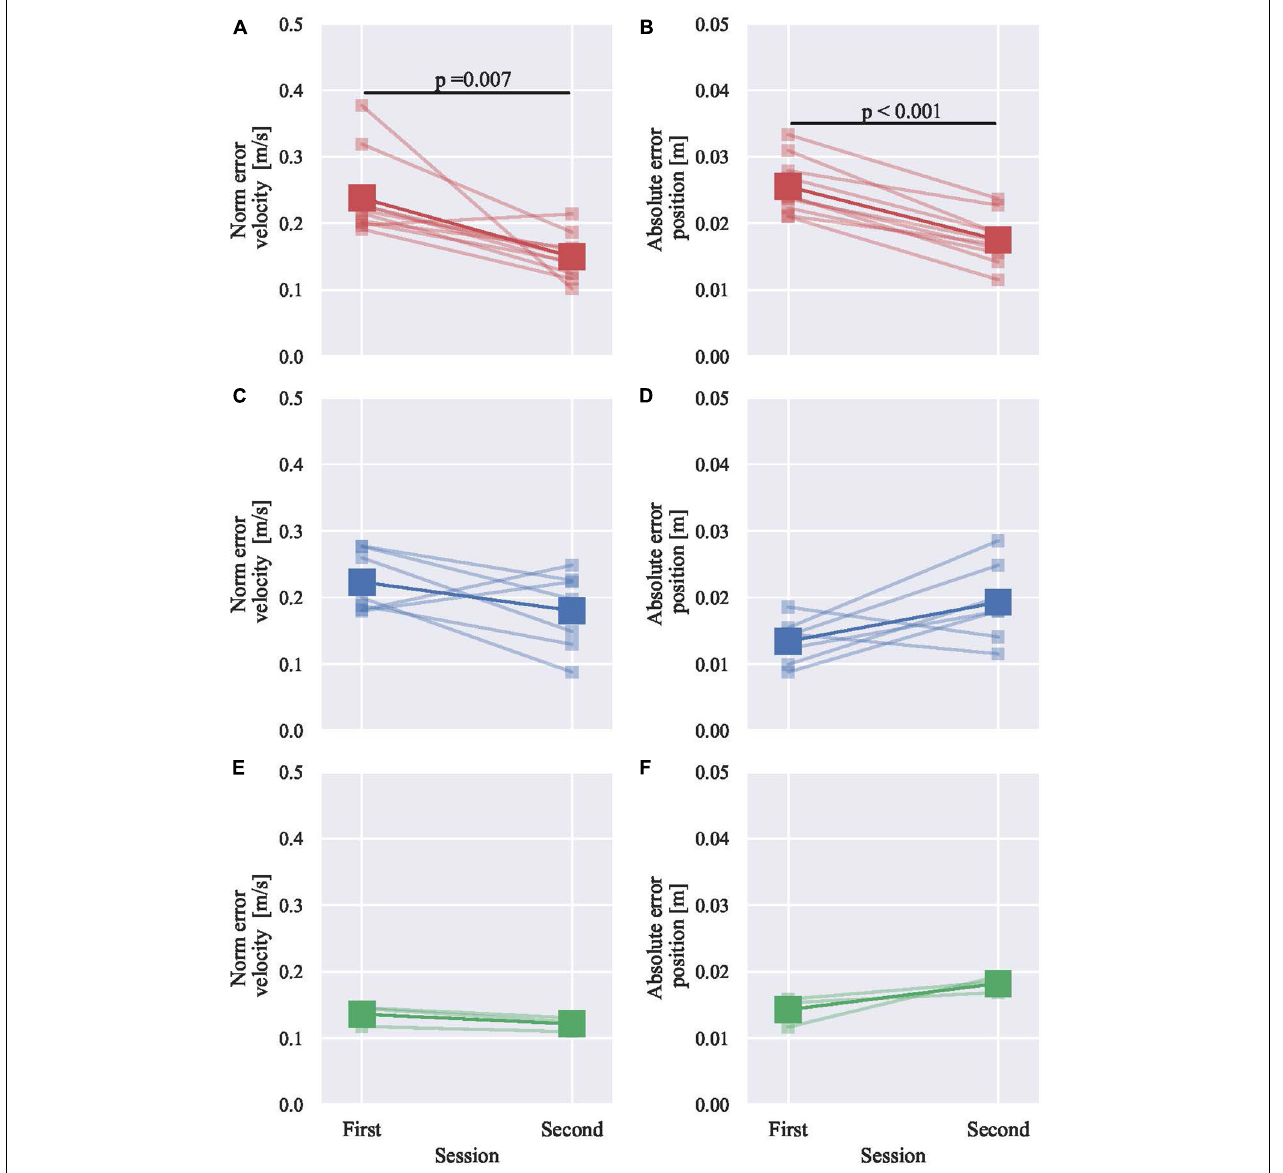
FIGURE 7 | The skill level change between sessions with participants grouping based on the derived boundaries. (A) Red group velocity. (B) Red group position. (C,D) Blue group and (E,F) Green group. The paired two-sample tests are Wilcoxon signed-rank test in (A) and Student’s t -test in (B) .